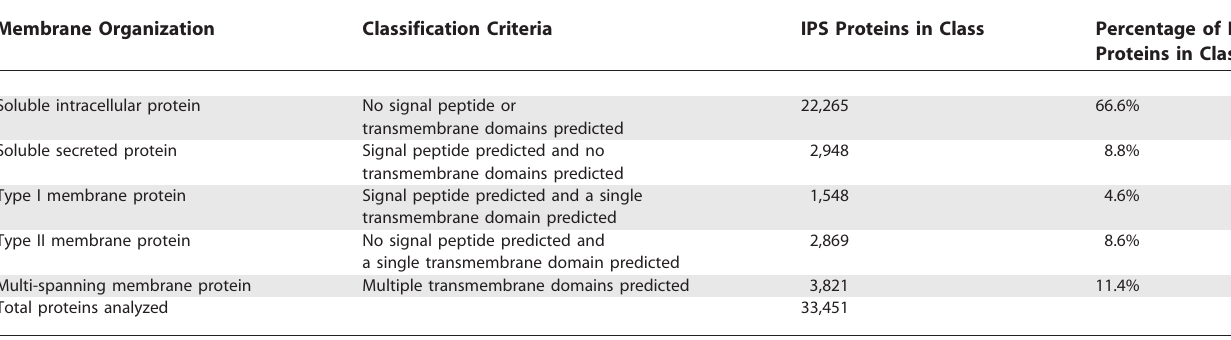
Table 1. Distribution of IPS Proteins between Five Membrane Organization Classes Membrane